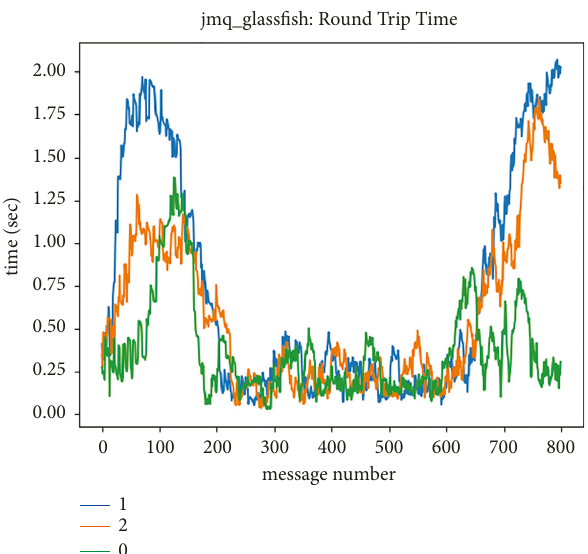
Figure 17: GlassFish’s RTT with three communicating process pairs.